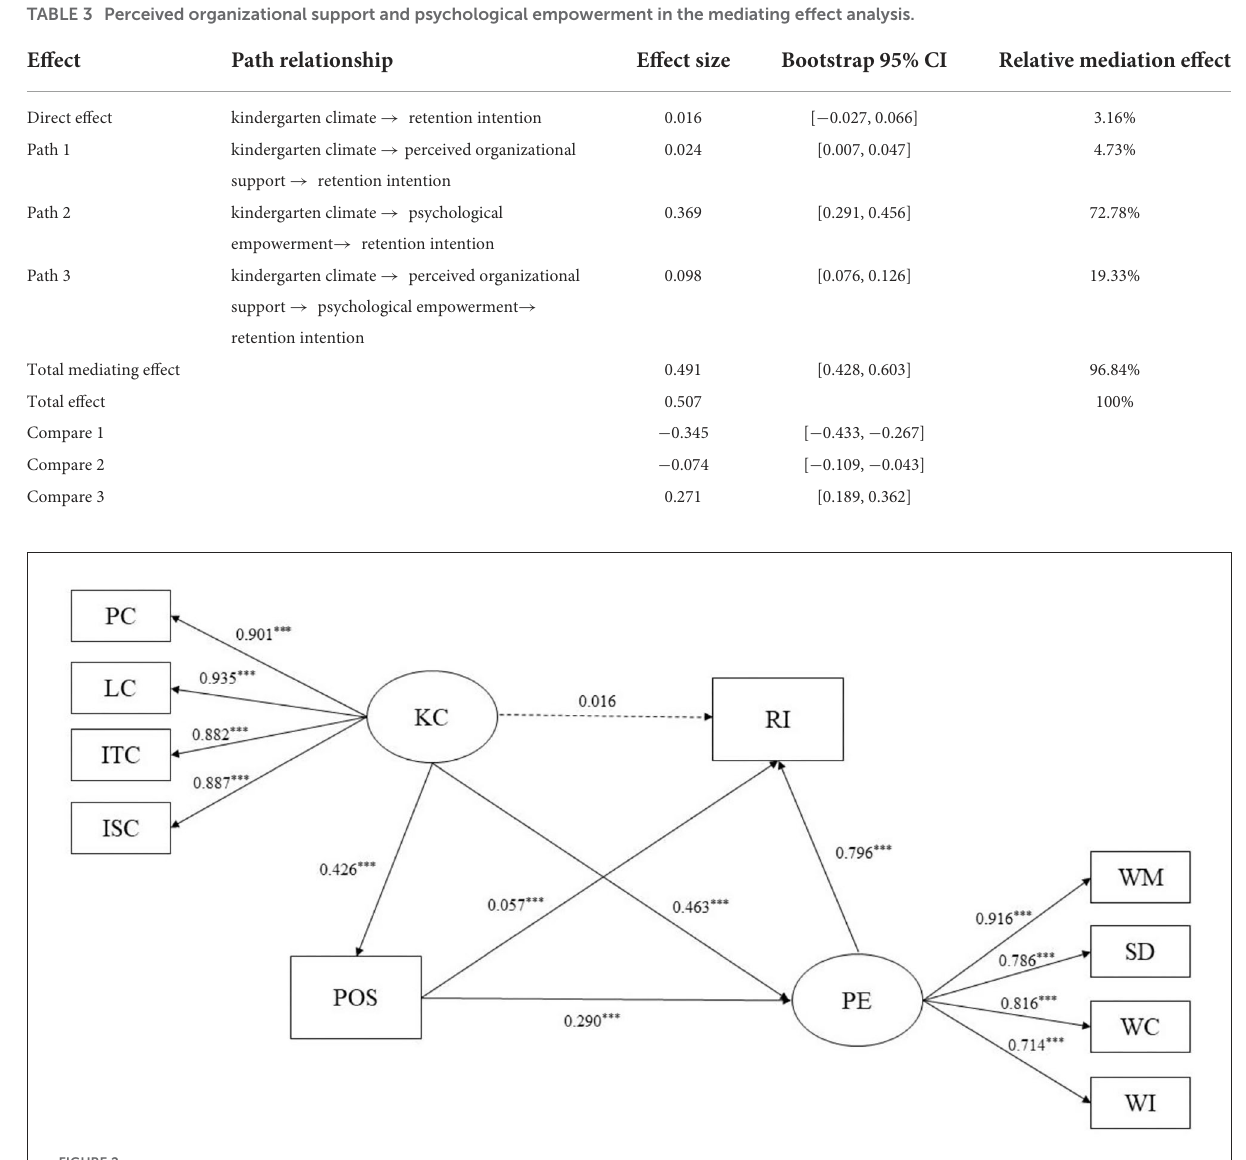
FIGURE2 The chain mediation model. *** p < 0.001. KC, kindergarten climate; RI, retention intention; POS, perceived organizational support; PE, psychological empowerment; PC, physical climate; LC, learning climate; ITC, interpersonal climate; ISC, institutional climate; WM, work meaning; SD, self-determination; WC, work competence; WI, work